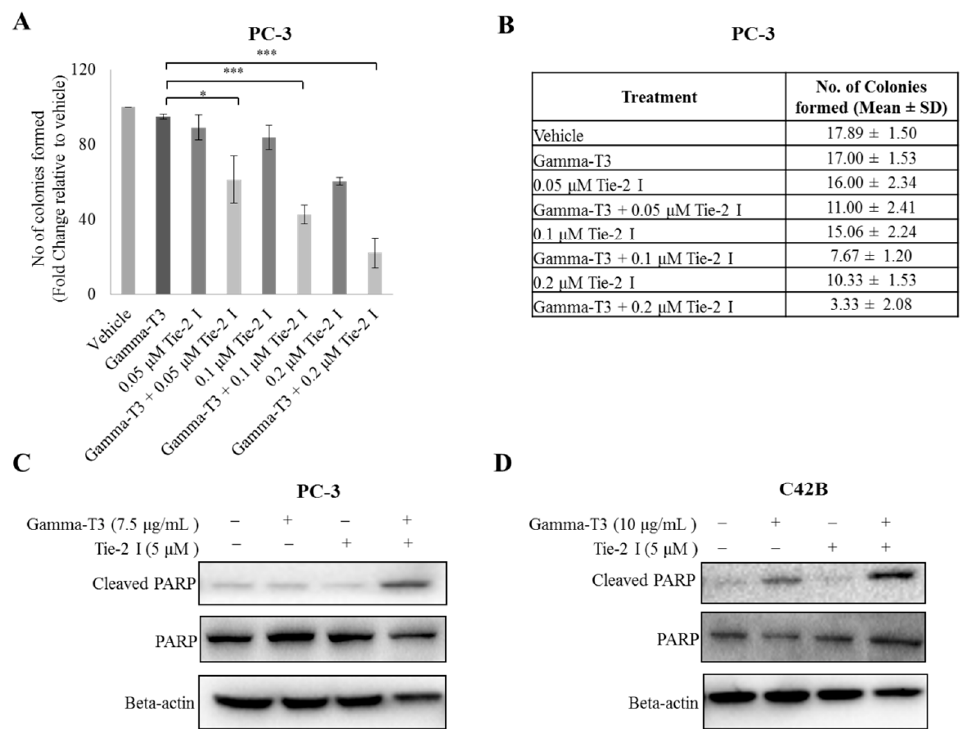
Figure 3. Inactivation of Tie-2 enhances the cytotoxic effect of γ -T3. PC-3 cells were treated with different combinations of Tie-2 inhibitor and γ -T3. ( A ) The number of colonies formed were stained and counted after 14 days ( A , B ). Protein expression of cleaved PARP, total PARP, and actin (as a loading control) in PC-3 ( C ) and C42B ( D ) cells after treating with Tie-2 inhibitor/ γ -T3 or both compounds was examined by Western blotting. Each experiment was repeated at least three times, and the results are presented as the mean ± SD with representative Western blots shown. ( p values: * <0.05; *** < 0.0005) .